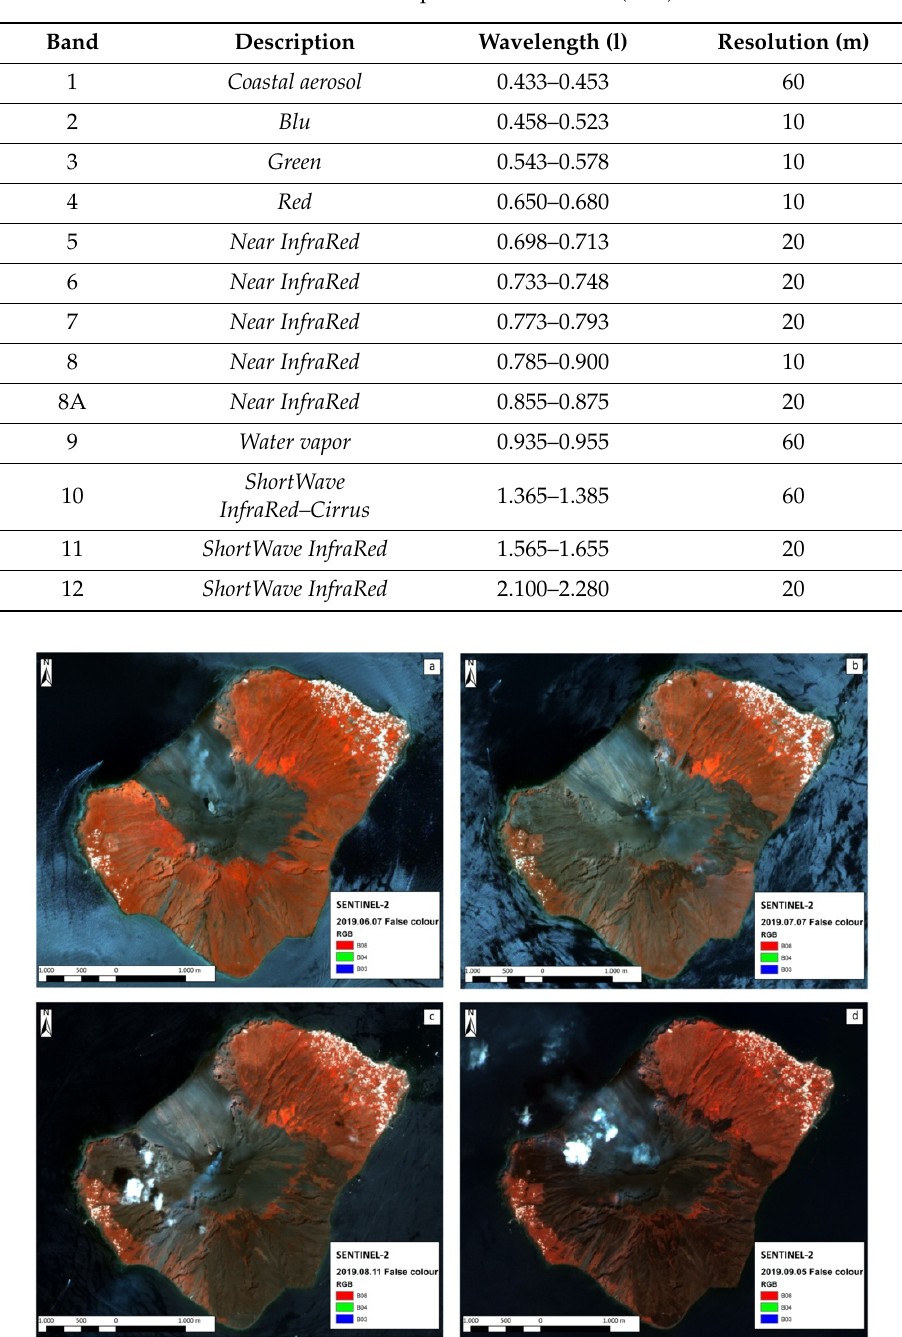
Table 2. Sentinel-2 Multi-Spectral Instruments (MSI) bands.